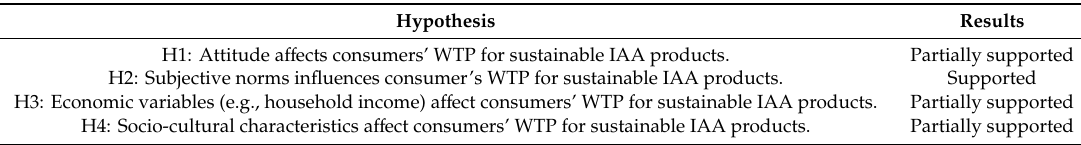
Table 9. Hypotheses testing